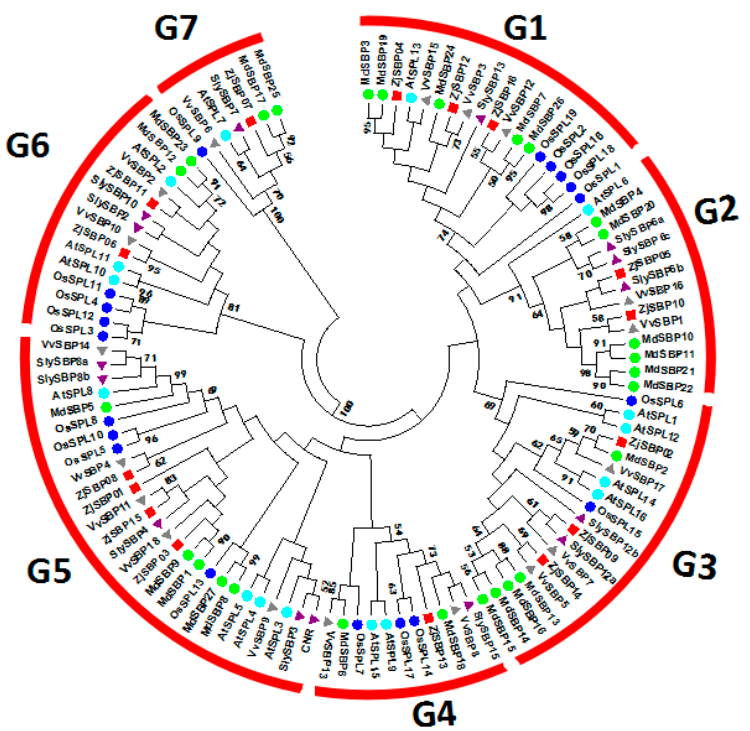
Figure 3. Phylogenetic analysis of jujube and other SBP-box families by MEGA 7.0. The sequences of the SBP domain are from Arabidopsis (AtSPL), apple (MdSBP), rice (OsSPL), tomato (SlySBP or CNR), grape (VvSBP) and jujube (ZjSBP). The sequences and the sources of other plants are in Tables S2 and S3.